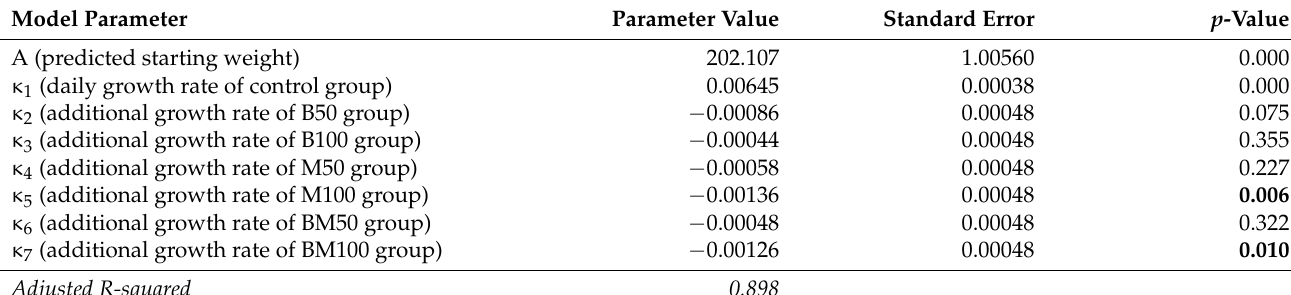
Table A2. Summary of the exponential growth model